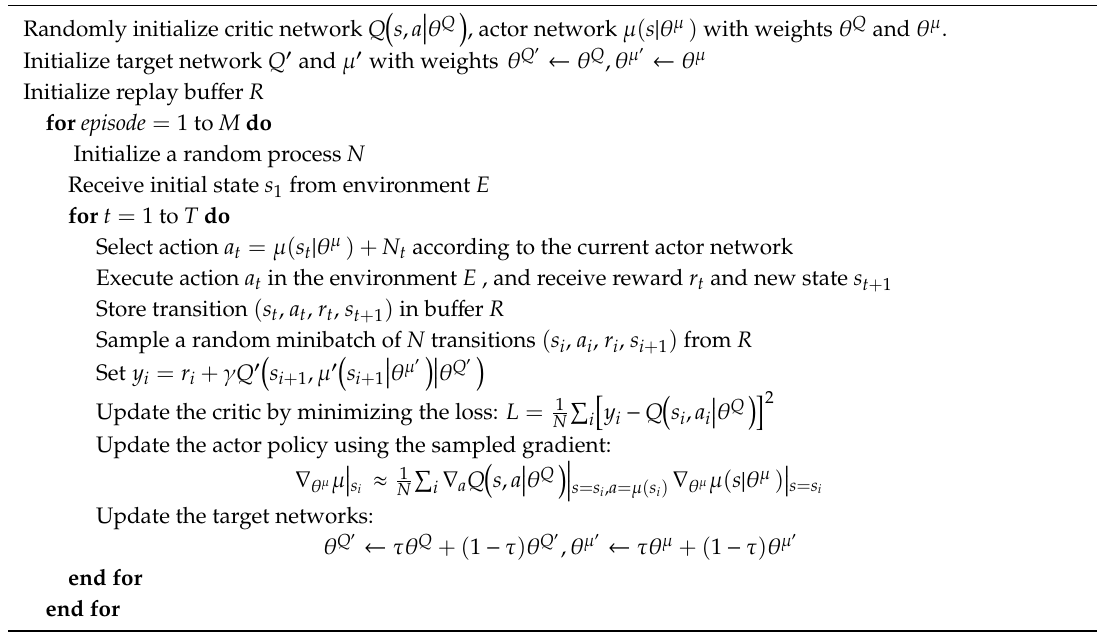
Algorithm 1. DDPG